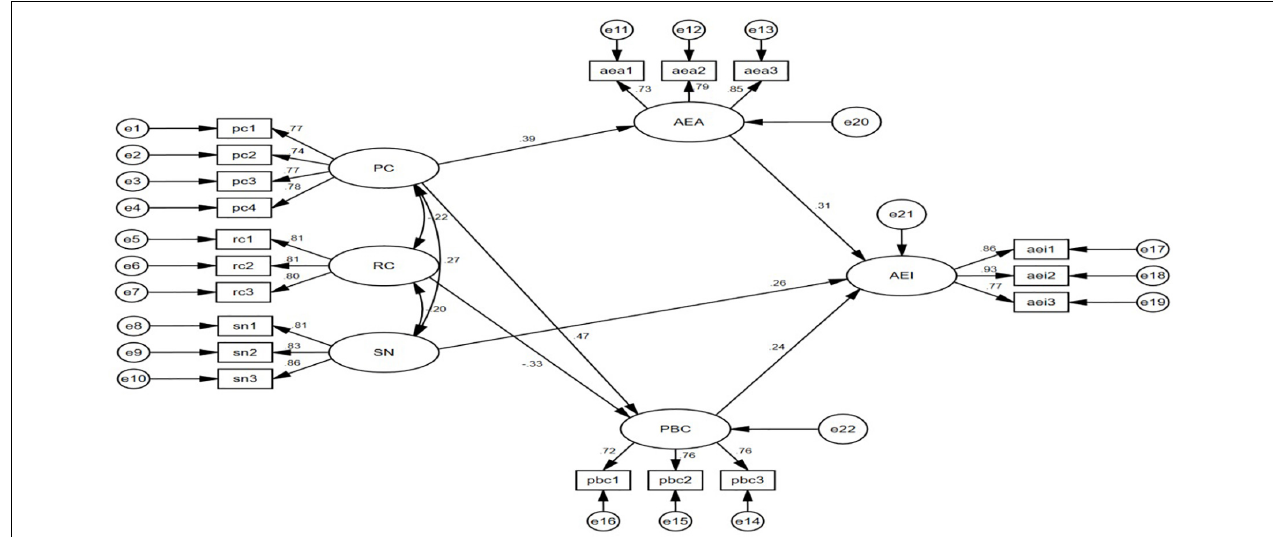
FIGURE 3 | Structural equation model.